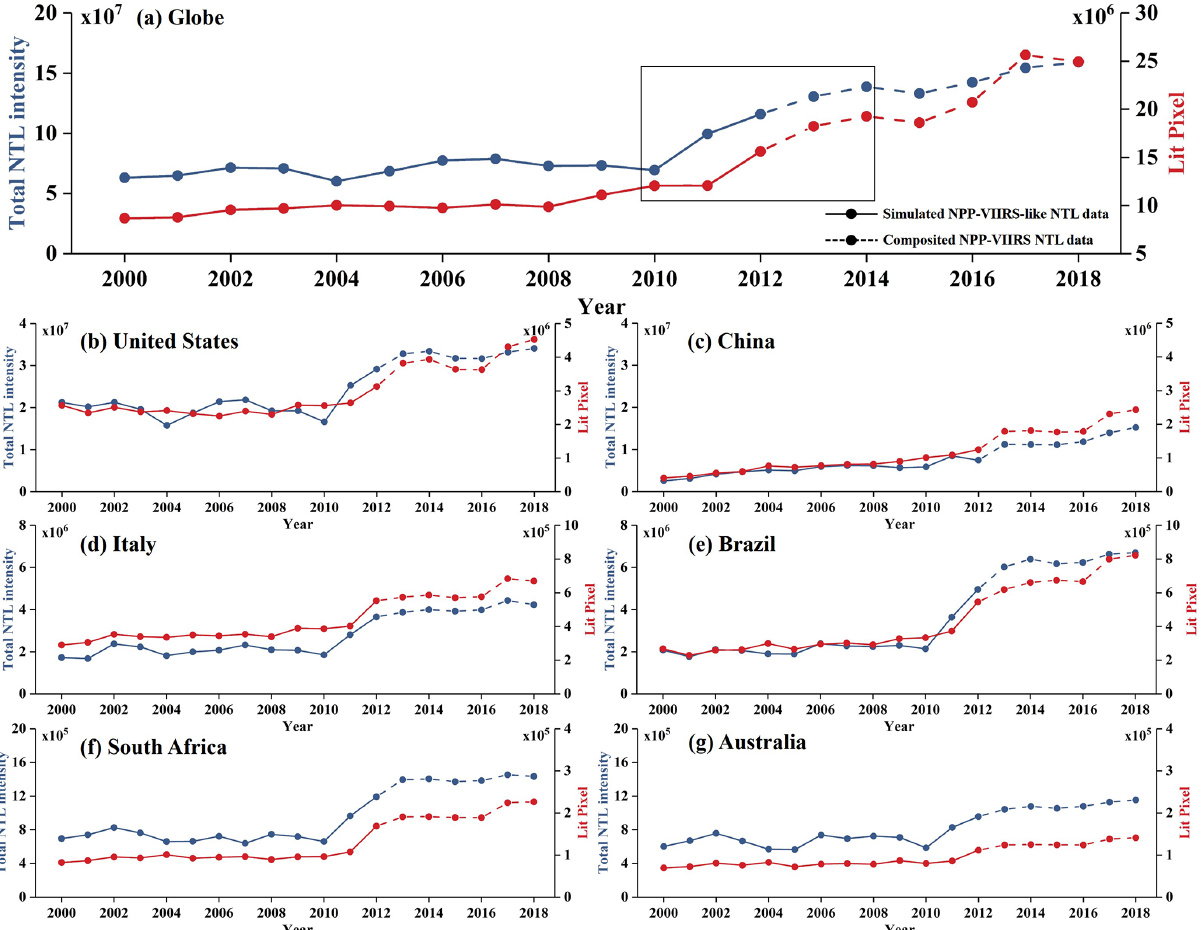
Figure 14. Temporal trend of extended time series (2000–2018) NPP-VIIRS-like NTL data for the total NTL intensity and lit pixels at (a) the global scale and within six selected countries: (b) United States, (c) China, (d) Italy, (e) Brazil, (f) South Africa, and (g)